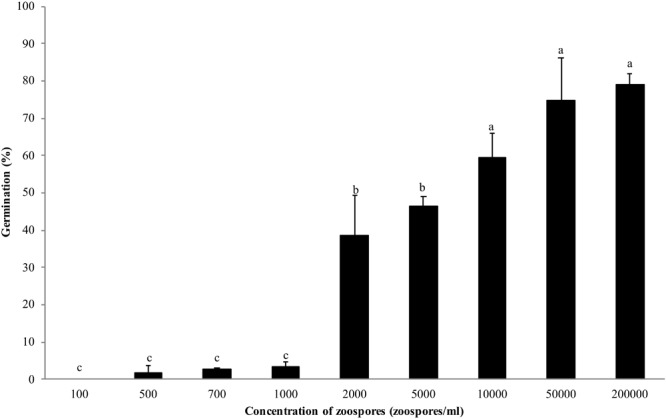
Germination of Phytophthora erythroseptica zoospores at various concentrations. Each bar represents the mean ± standard deviation. Means followed by different letters are significantly different (P < 0.05) according to Fisher’s protected least significant difference.